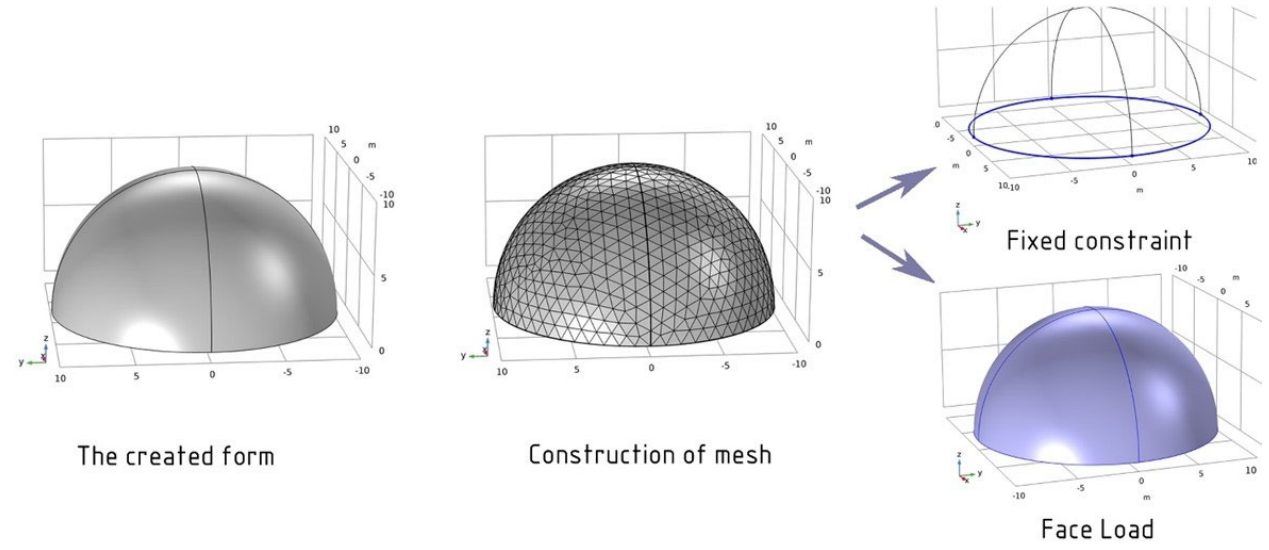
(minimum). The total elastic strain energy is 9020.16 J. Figure 4 represents a graphical diagram showing the maximum and minimum values. Figure 3. Scheme of preparation of the sphere shell for calculation. Figure 3. Scheme of preparation of the sphere shell for calculation.